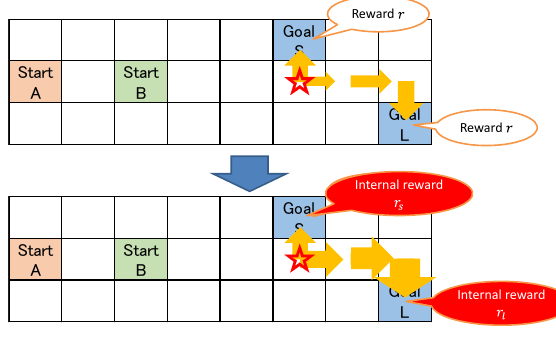
Figure 6: Internal